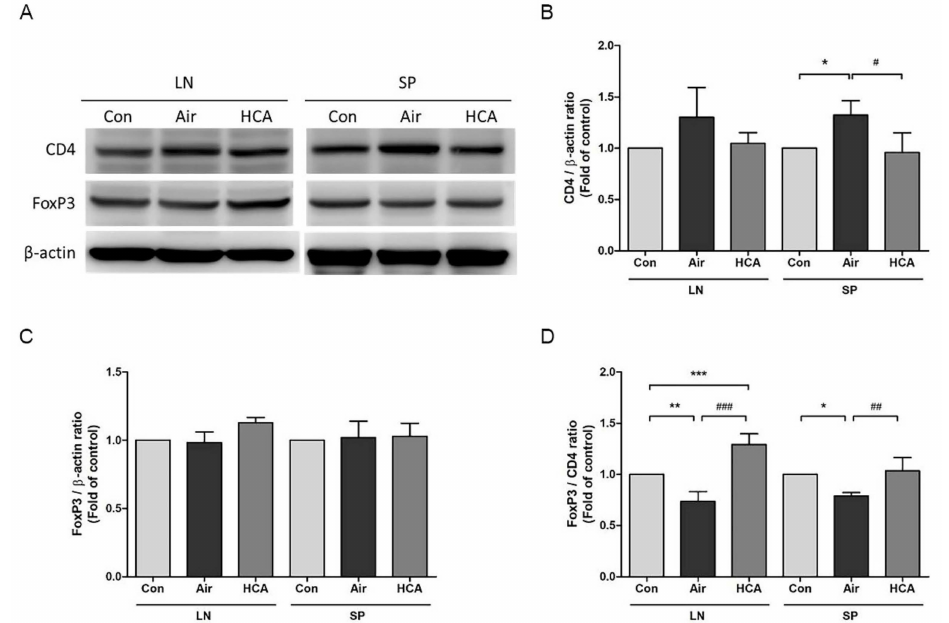
Figure 6. Expression levels of CD4 and FoxP3 protein in draining lymph nodes and spleen. ( A – D ) Protein expression levels of CD4 and FoxP3 from draining lymph nodes and spleen extracts on day 3 after transplantation were quantified by Western blotting. A representative result of at least three independent experiments is shown. ( n = 3 mice/group). * p < 0.05; # p < 0.05; ** p < 0.01;